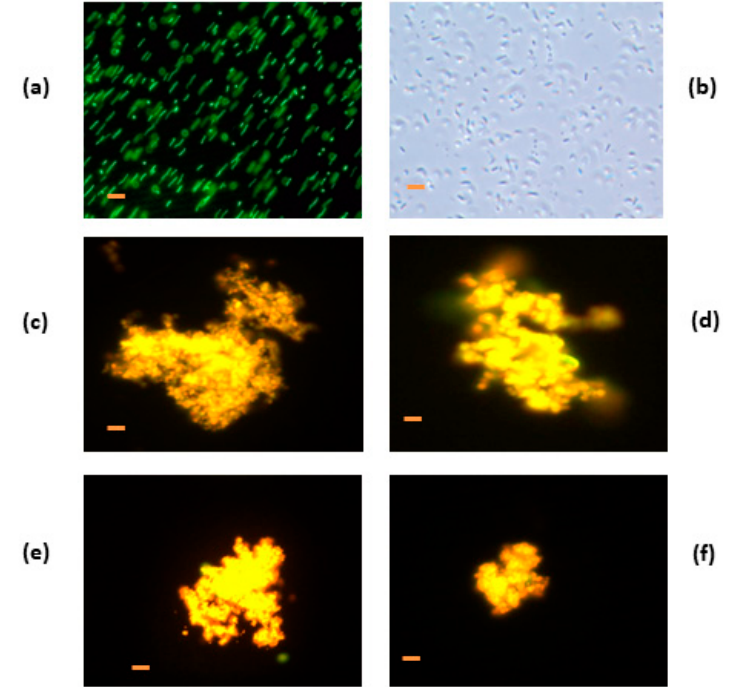
Figure 4. Fluorescence micrographs of Escherichia coli incubated with heat-treated hen egg white lysozyme (HEWL) at pH 6.0. ( a ) E. coli control without HEWL, ( b ) E. coli control without HEWL without fluorescence, ( c ) E. coli incubated with HEWL/80 °C at pH 6.0, ( d ) E. coli incubated with HEWL/90 °C at pH 6.0, ( e ) E. coli incubated with HEWL/95 °C at pH 6.0, and ( f ) E. coli incubated with HEWL/120°C, pH 6.0. Bacteria control and bacteria with sample were incubated for 15 h at a concentration of 0.5 mg/mL. Bar = 2 μ m.